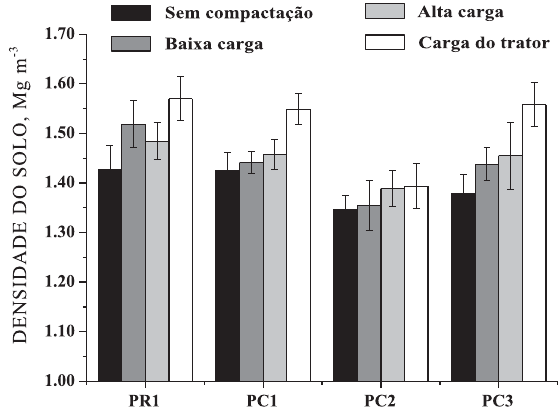
Figura 3. Densidade média do solo na camada de 0– 0,30 m em cada local em função dos tratamentos com diferentes níveis de pressão nele exercida. As barras indicam o intervalo de confiança (95 %). As médias são estatisticamente diferentes quando não ocorre sobreposição das